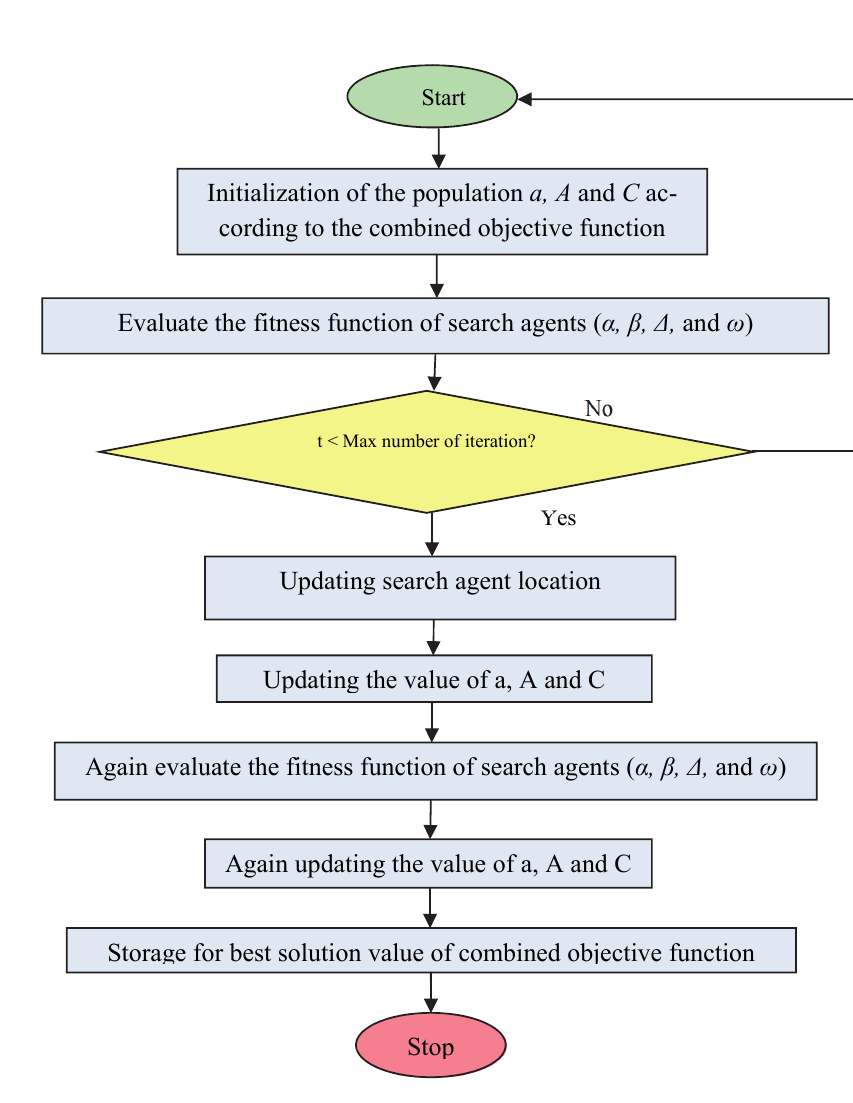
Fig. 1. Flowchart of grey wolf optimization algorithm